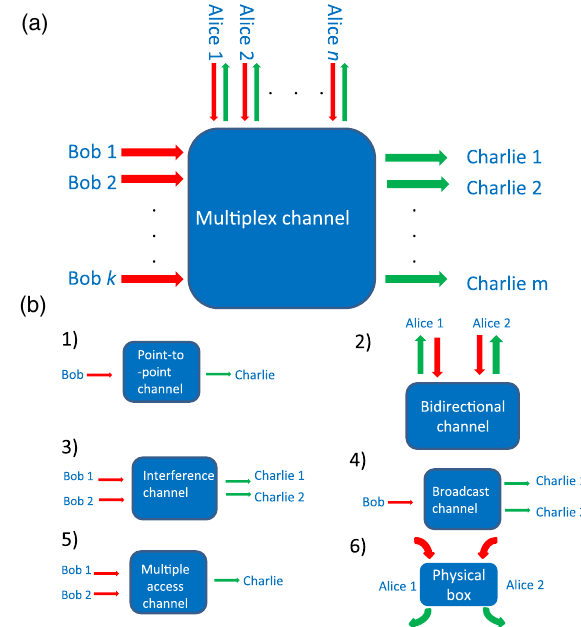
FIG. 1. Pictorial illustration of the universal nature of a multiplex quantum channel from which all other network quan- tum channels arise, where red and green arrows show inputs and outputs to channels, respectively; see Sec. III B for definitions.